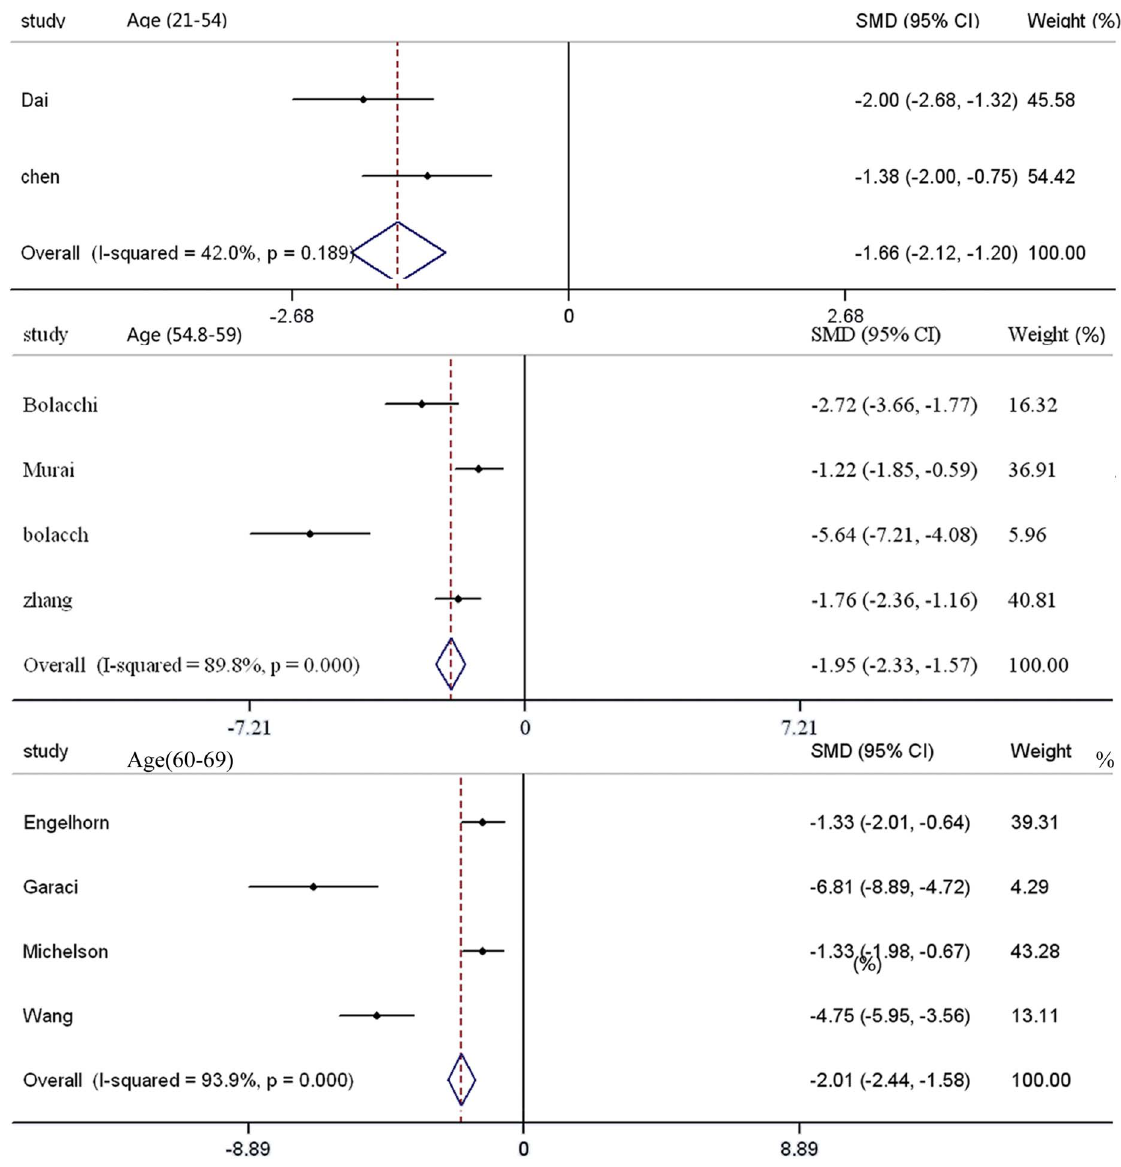
Figure 5. Results of an FA analysis with respect to age in the optic nerve of patients with glaucoma compared with controls. There is an apparent difference between three age groups (a: age 21–54 years, b: age 54.8–59 years, and c: mean age 60–69 years). We can conclude that there was deceasing FA of the optic nerve with increasing age in patients with glaucoma (P , 0.05 and the diamond shape appears on the left side). FA: fractional anisotropy; SMD: standardized mean difference; CI: confidence